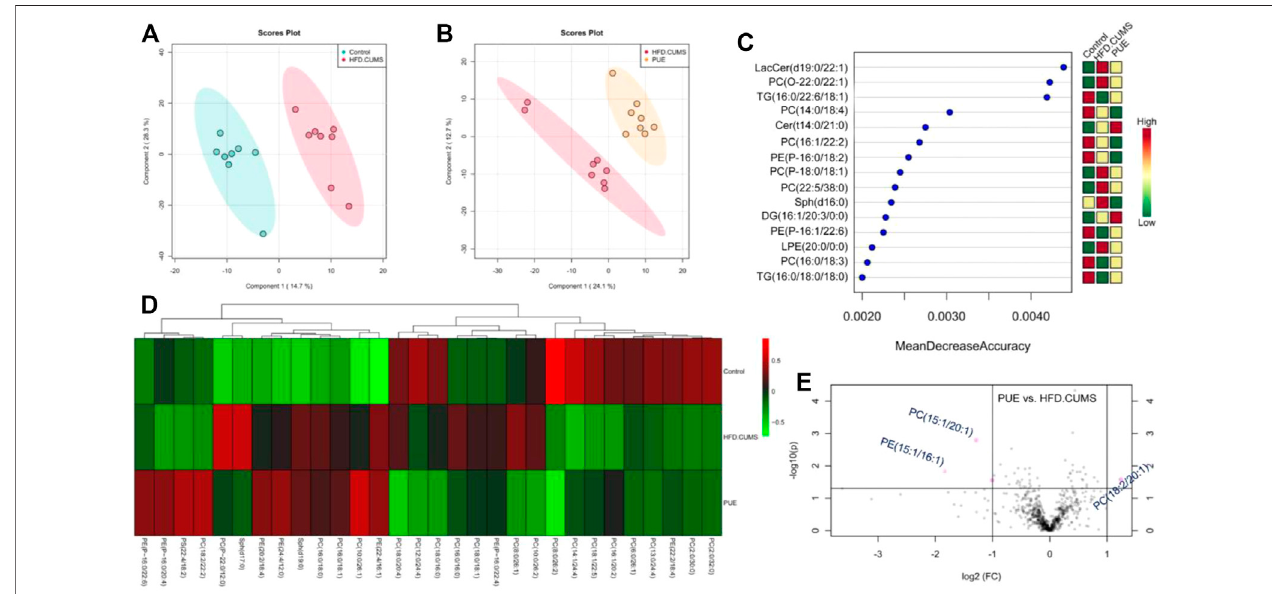
FIGURE 6 | Puerarin-modi fi ed lipid metabolism abnormalities in HFD/CUMS-induced rat hippocampal tissues. (A) PLS-DA score plot based on the control vs. HFD/CUMS groups. (B) PLS-DA score plot based on HFD/CUMS vs. PUE groups. (C) Random forest analysis of the top 15 most different metabolites among the control, HFD/CUMS, and PUE groups. “ Mean Decrease Accuracy ” and “ Mean Decrease Gini ” were used to measure the importance of a metabolite in discriminating groups in a random forest. The greater the two values, the greater the importance of metabolites in the random forest. (D) Heatmap of different phospholipid metabolites. (E) Volcano plot based on PUE vs. HFD/CUMS. The identi fi ed biomarkers were PC (15:1/20:1), PE (15:1/16:1), and PI (18:2/20:1). LacCer: lactosylceramide, TG: triglyceride, Sph: sphingolipid, PC: phosphatidylcholines, Cer: ceramide, PE: phosphatidylethanolamine, LPE: lyso-PE, DG: diacylglycerols, and PI: phosphatidylinositol. Values are expressed as mean ± S.E.M ( n (cid:2) 8).